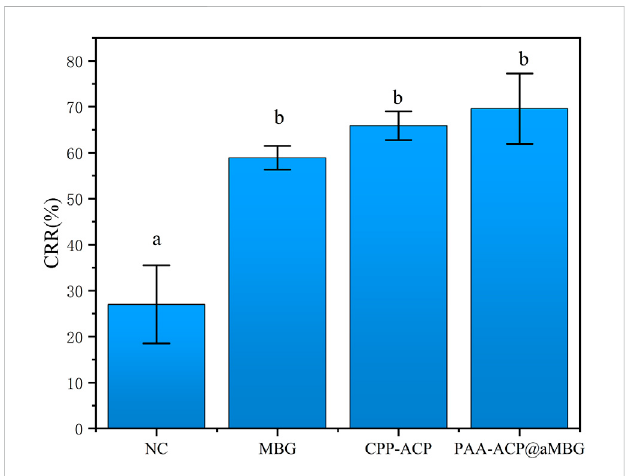
FIGURE 5 Color recovery rate (CRR) in the four groups. The same letter indicates that the difference wasn ’ t signi fi cant ( p > 0.05).